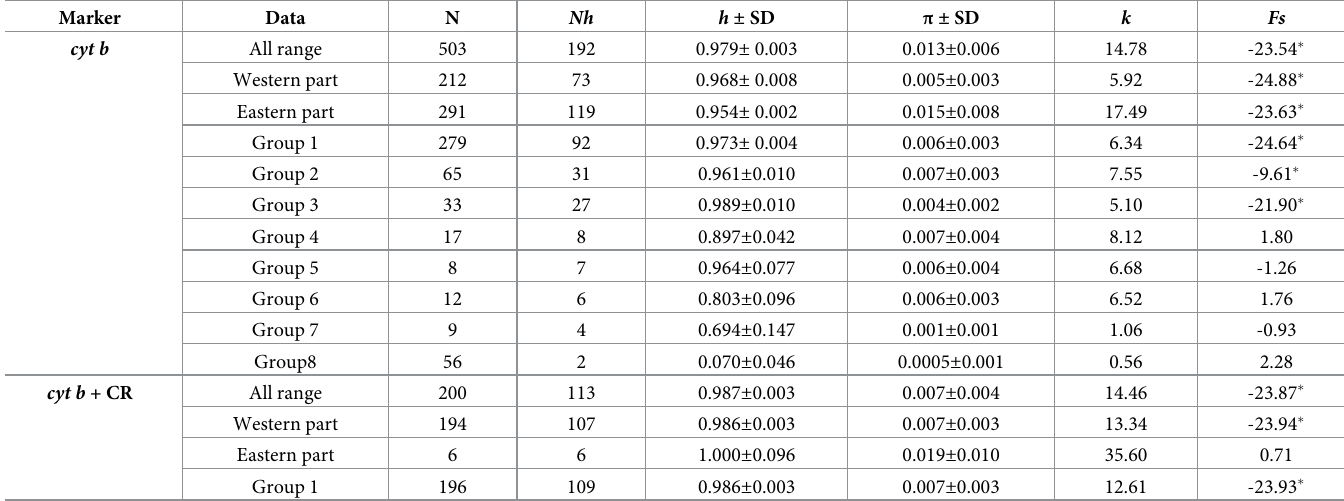
N–number of sequences; Nh –number of haplotypes; h –haplotype diversity; π –nucleotide diversity; k –mean number of pairwise differences; SD–standard deviation; Fs – values of Fu’s test of selective neutrality � P � 0.05